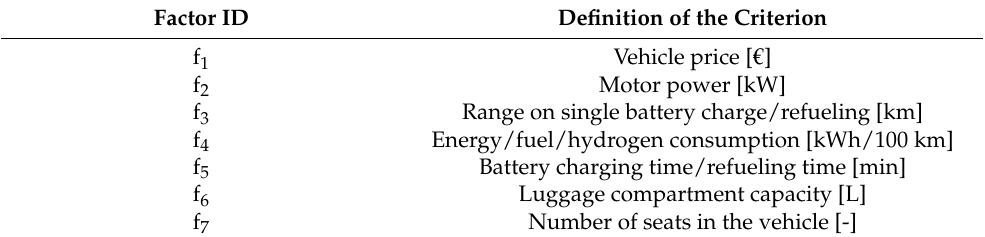
Table 3. Criteria for selecting vehicles for the car-sharing fleet. Factor ID